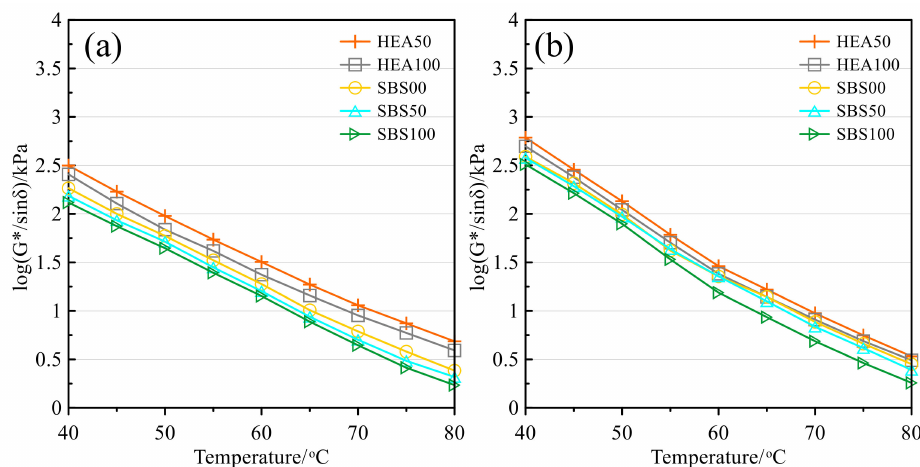
Figure 7. Rutting factor: ( a ) Before TFOT; ( b ) After